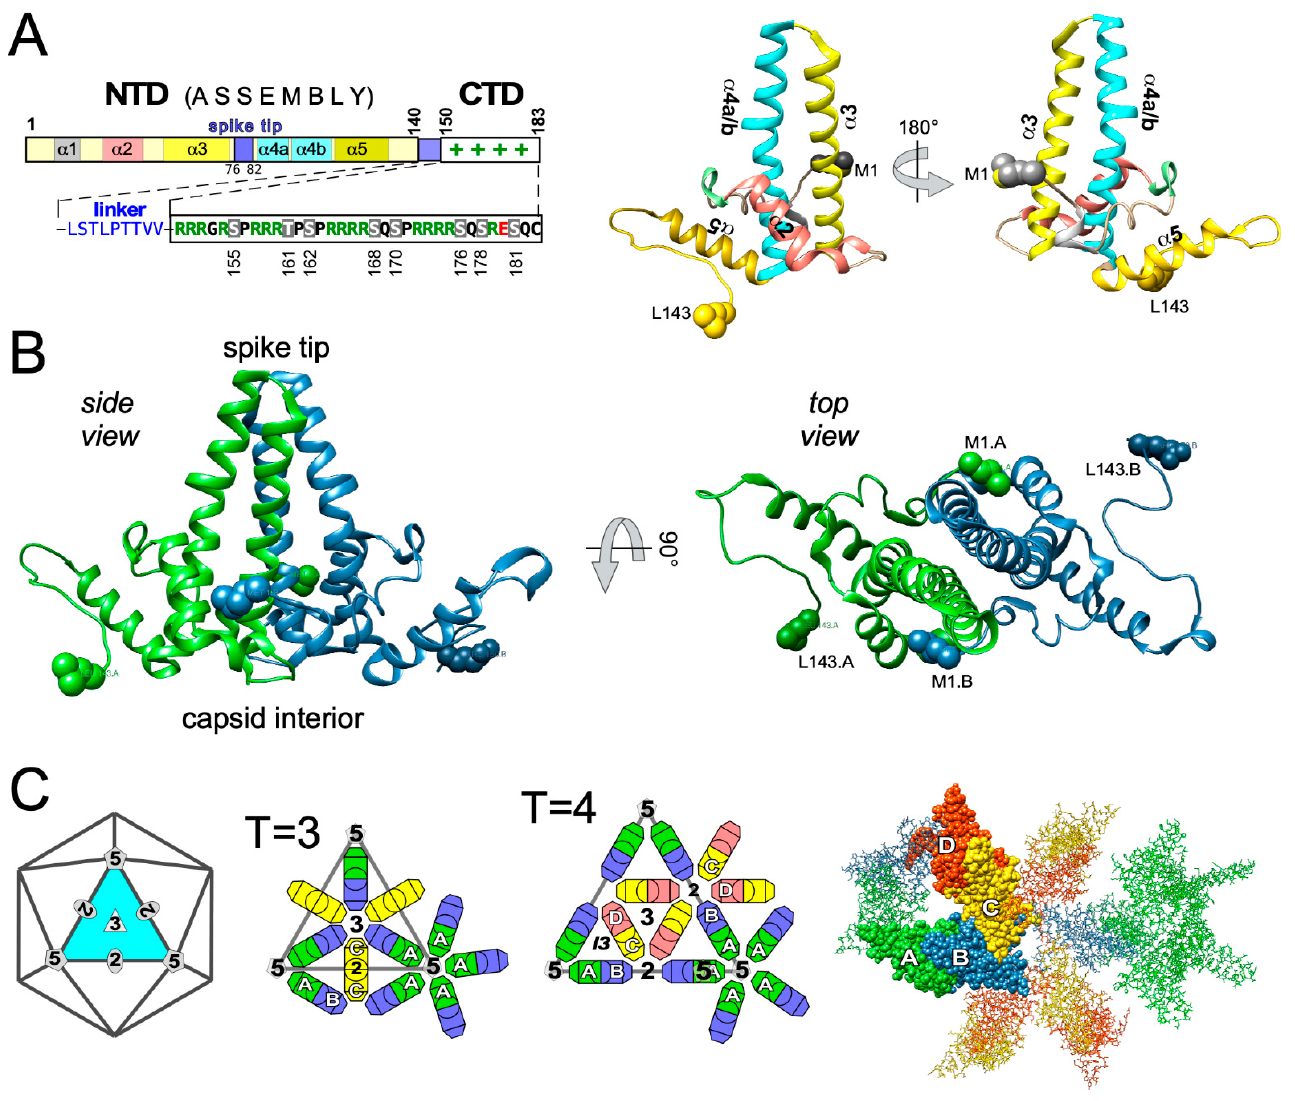
Figure 4. Basic structural features of HBV Cp. ( A ) Primary sequence and its correlation to the fold of the NTD. The bars symbolize the N terminal assembly domain (NTD), the linker (blue), and the basic nucleic acid binding C terminal domain (CTD). Numbers indicate amino acid positions, + signs the clustered R residues in the CTD. The linker and CTD sequences are explicitly shown. S and T residues in the CTD that are potential phosphorylation targets are highlighted; in recombinant Cp183 SRPK1 phosphorylates all but S181 and thereby blocks RNA binding. The models on the right (derived from PDB 6HTX) show two views of one monomer with the all- α -helical fold of the NTD. M1 and L143 are highlighted as spheres, the larger helices α 2 to α 5 are color-coded as in the linear representation on the left. The CTD is likely disordered and not resolved in current structures. ( B ) The Cp dimer. One monomer is shown in green, the other in blue. Dimerization relies on formation of a four-helix-bundle by the α 3/ α 4 hairpins from two monomers, generating a prominent spike; in addition, the N terminal sequences embrace the spike base, as is most easily seen in the top view. ( C ) Cp dimer assembly into icosahedral capsid shells. On the left an icosahedron with its defining 2-fold, 3-fold, and 5-fold symmetry axes at one of the 20 triangular faces is shown. Cartoons in the center show the arrangement of Cp dimers in T = 3 and T = 4 particles. A subunits (green) cluster around 5-fold axes, B (blue) and C (yellow) subunits around 3-folds. The two C subunits are related by 2-fold symmetry and thus identical. In the larger T = 4 particle the two halves of the non-AB dimers are in distinct environments and thus termed C (yellow) and D (red). Counting the dimers per triangular face yields 4.5 for T = 3 and 6 for T = 4, hence totally 90 and 120 dimers, respectively. The model on the right shows the asymmetric unit, i.e., neighboring AB and CD dimers (residues as spheres), as seen in the context of a real T = 4 CLP (6HTX).